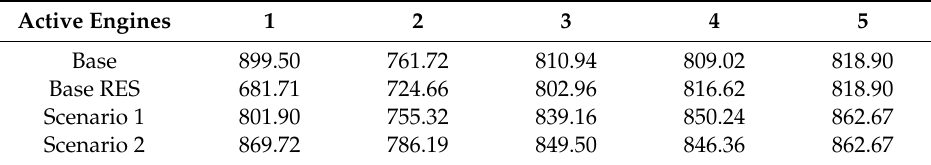
Table 7. Average power per number of active engines.